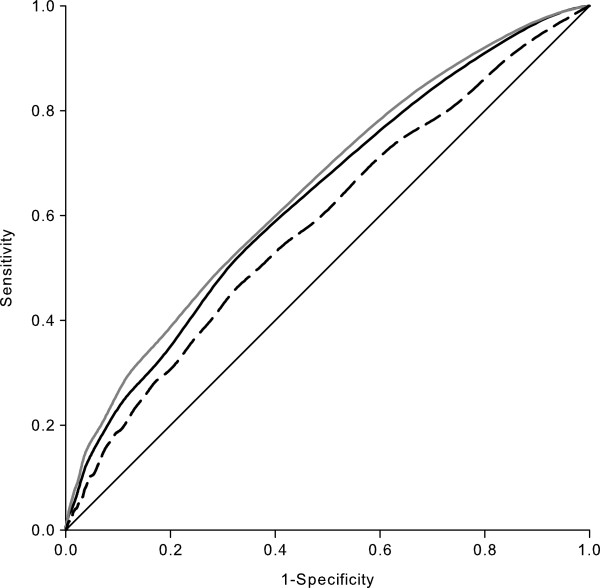
Receiver operating characteristic curves for the unrecognized myocardial infarction assessment tools. Basic assessment tool (solid black line), expanded assessment tool (solid gray line), and Framingham risk score for coronary heart disease (dashed black line).